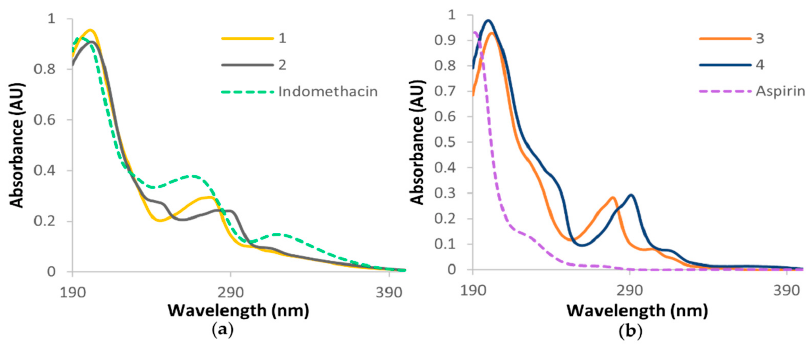
Figure 4. The UV spectra of ( a ) 1 , 2 and indomethacin and ( b ) 3 , 4 and aspirin, in water.